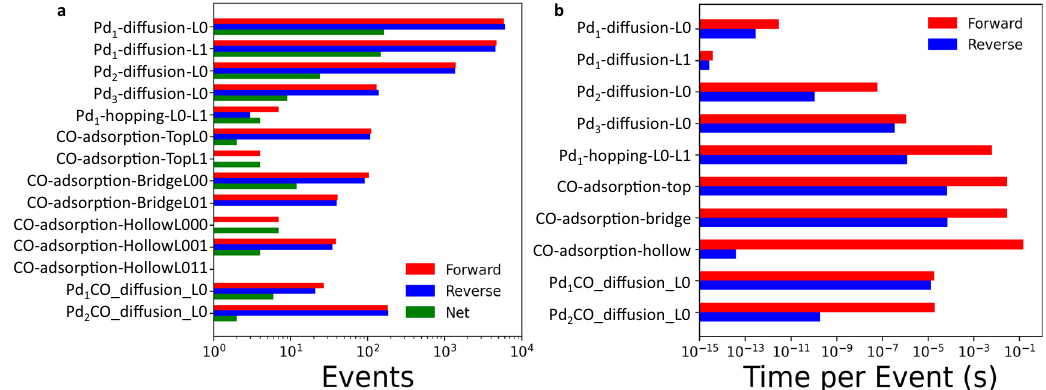
Fig. 2 Illustration of disparity in time scales of microscopic events. a Scaled event frequency and b actual average time per event (without prefactor scaling) in a KMC simulation starting from a 0.05 coverage of single atoms at 300 K and P CO = 0.1 bar at long times (over 168 experimental time scales. For each complex represented as Pd n CO m , a Gaussian process (GP) 30 model is trained from tri- plicate runs. The GP models, using a standard Matérn kernel, are well suited to time-series data analysis and re fl ect the averages and uncertainties as a function of time 31 .